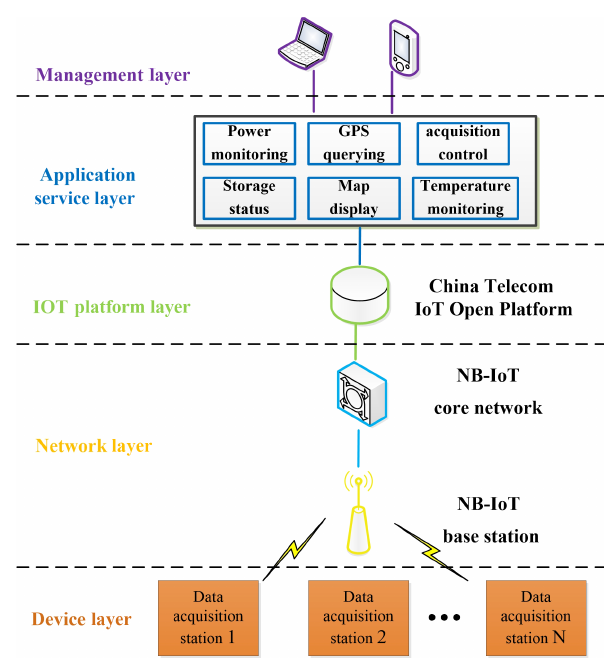
Figure 7. A flow chart representation of the NB-IoT communica-